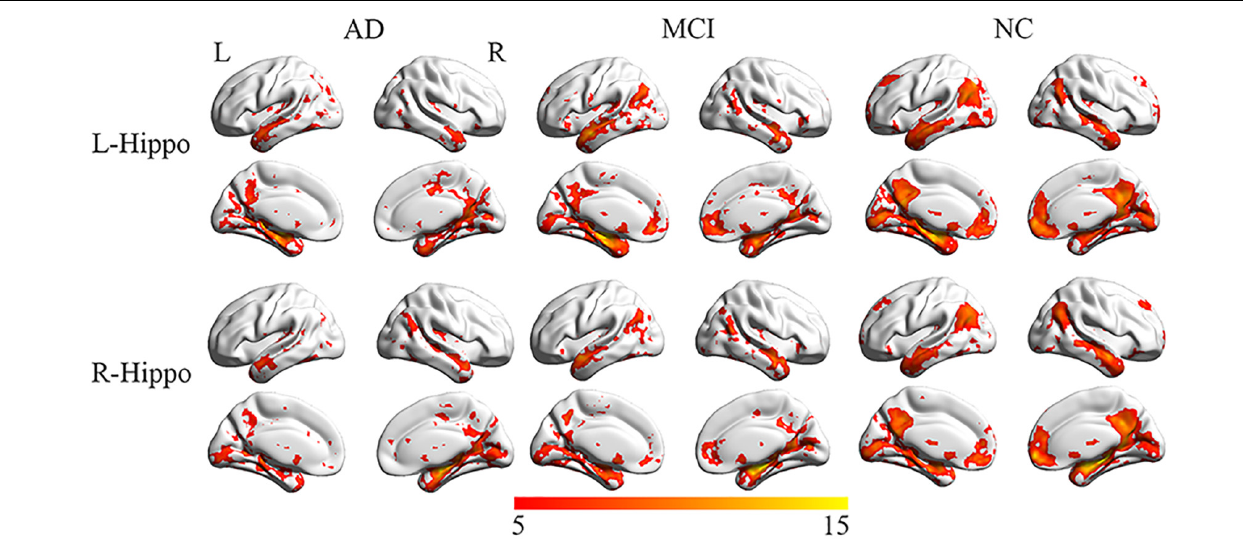
FIGURE 2 | Representation of connectivity of the left and right hippocampus to multiple cortical regions in AD, MCI, and NC groups. Although connections to multiple regions are noted in AD and MCI, their number and extent are reduced compared to NC.